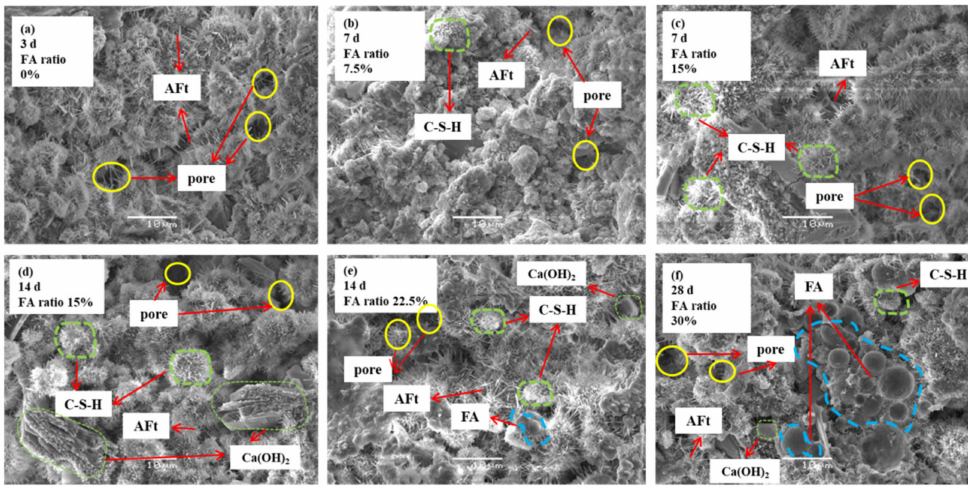
Figure 6. SEM micrograph under different curing ages and different fly ash content ( a – f